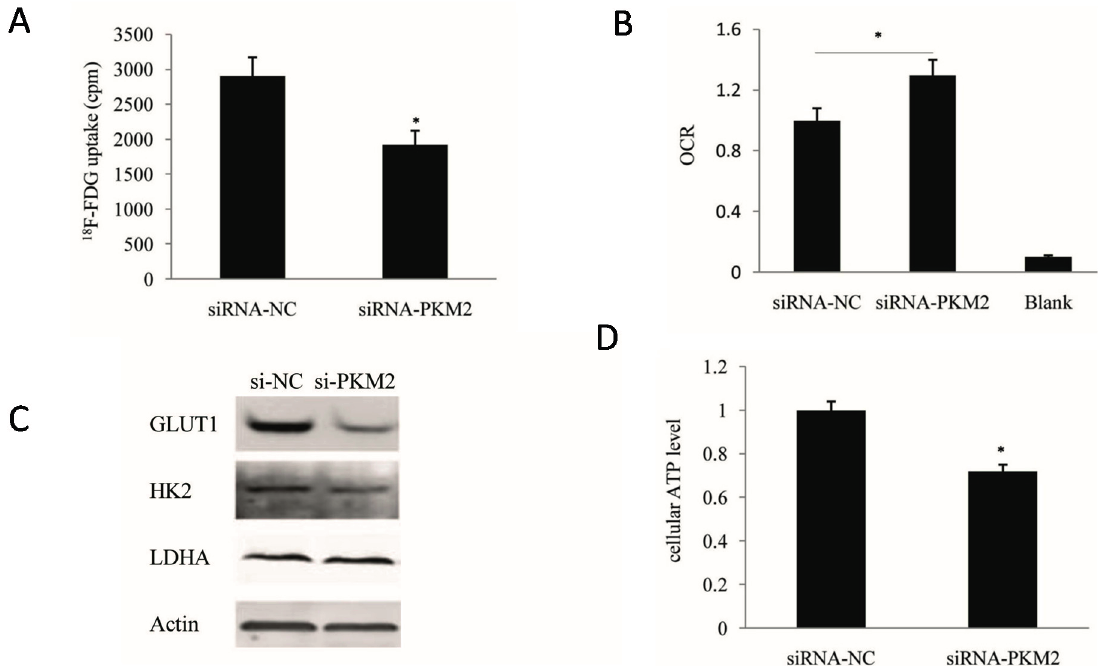
Figure 4. Inhibition of the Warburg effect in A549 cell lines by si- PKM2 . ( A ) Comparison of glucose uptake between si- PKM2 A549 cells and control si-NC A549 cells. At 72h post-transfection, A549 cells were incubated in DMEM with 18 F-FDG for 1 h and uptake radioactivity was measured using the well γ -counter; ( B ) Oxygen consumption of A549 cells was determined by the use of the seahorse at 72 h post-transfection with siRNA; ( C ) Influence of PKM2 siRNA on glycolytic enzymes in A549 cells; ( D ) Quantification of ATP levels in si-NC and si- PKM2 A549 cells using a luciferin/luciferase-based assay at 72 h post-transfection. * p < 0.05. The data shown are representative of three separate